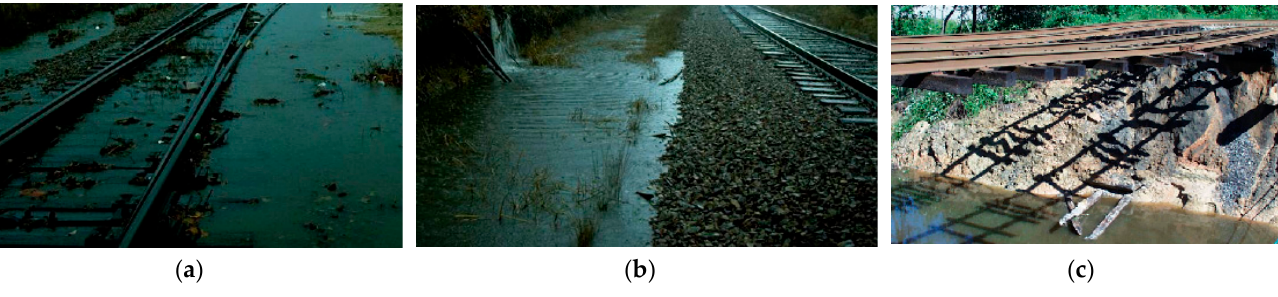
Figure 3. Typical track conditions caused by flood or heavy rain: ( a ) ballast drawn in water,( b ) sub- grade drawn in water, ( c ) fully unsupported sleepers caused by ballast and subgrade washing away.